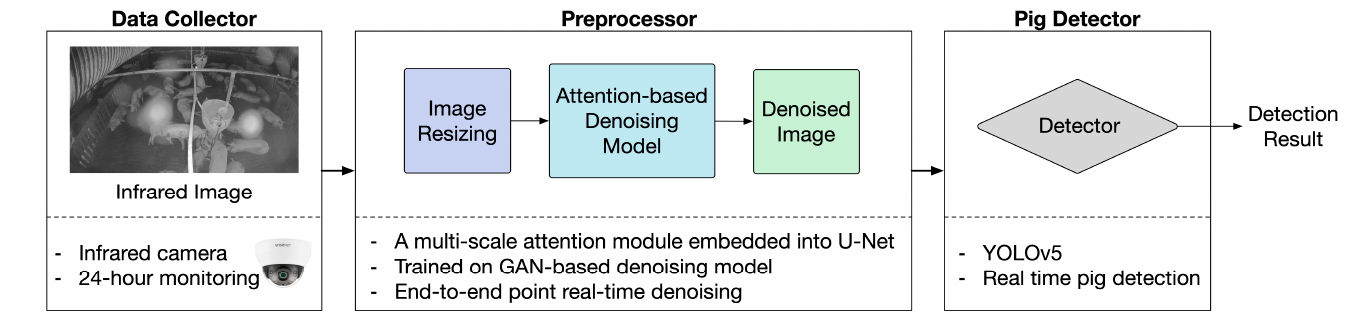
Figure 3. Overall structure of the proposed noise ‐ robust, real ‐ time, camera ‐ based pig detection sys ‐ tem.